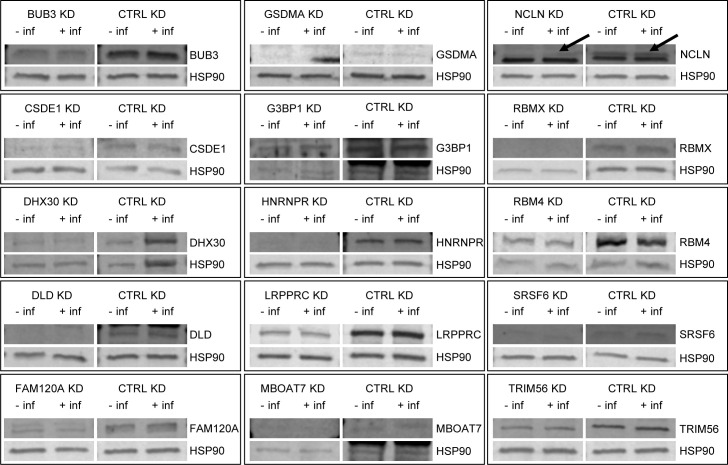
Western blots confirm efficacy of siRNA knockdown strategy.Commercially available antibodies against the 20 host proteins were obtained to detect each protein in cells with and without siRNA knockdown of that protein. Cells were transfected with the appropriate siRNAs, infected with the HIV reporter virus previously described, then lysed at 48 hr post-incubation with the virus. The protein bands at the expected molecular weights were quantified for siRNA treated cells and untreated cells and the efficiency of protein knockdown calculated (Supplementary file 6). Of the 20 host proteins targeted, two (SRRM2, MW 300 kDa and DYNC1H1, MW 530 kDa) did not produce quantifiable results, likely due to molecular weight limitations of the western blot parameters, and three (DNM2, IGF2BP3, RPL15) did not produce data to indicate successful knockdown of the proteins. Related to Supplementary files 5 and 6.